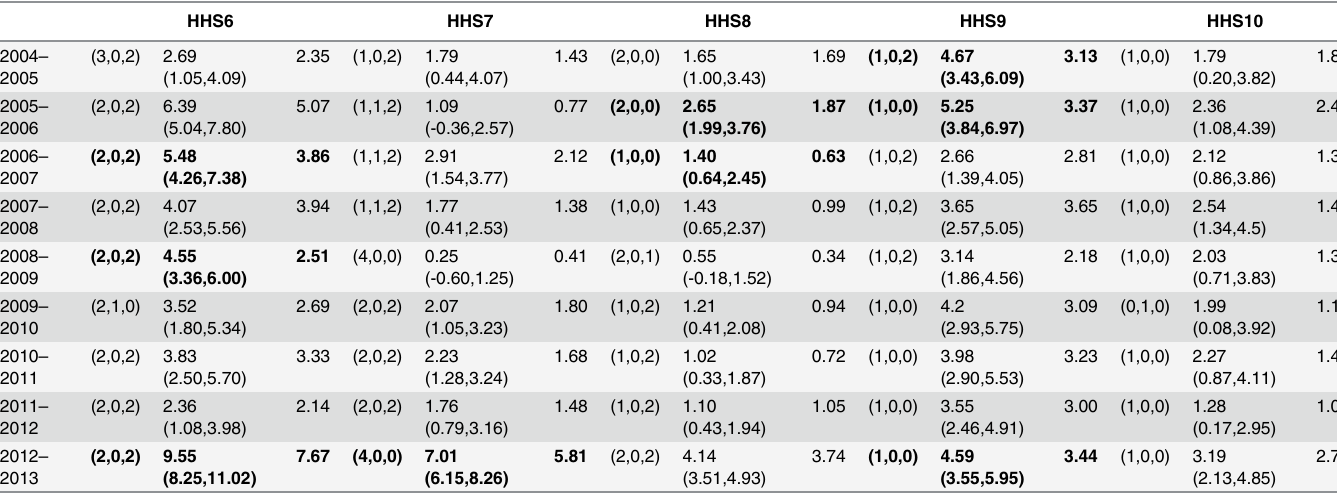
Table 4. Week 1 ILI rate prediction for HHS regions 6 – 10 from influenza seasons 2004 – 2005 to 2012 –